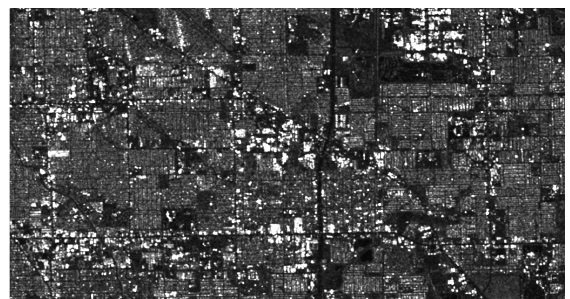
Figure 4. SAR images of a partial area of Houston. Remote Sens. 2023 , 15 , x FOR PEER REVIEW